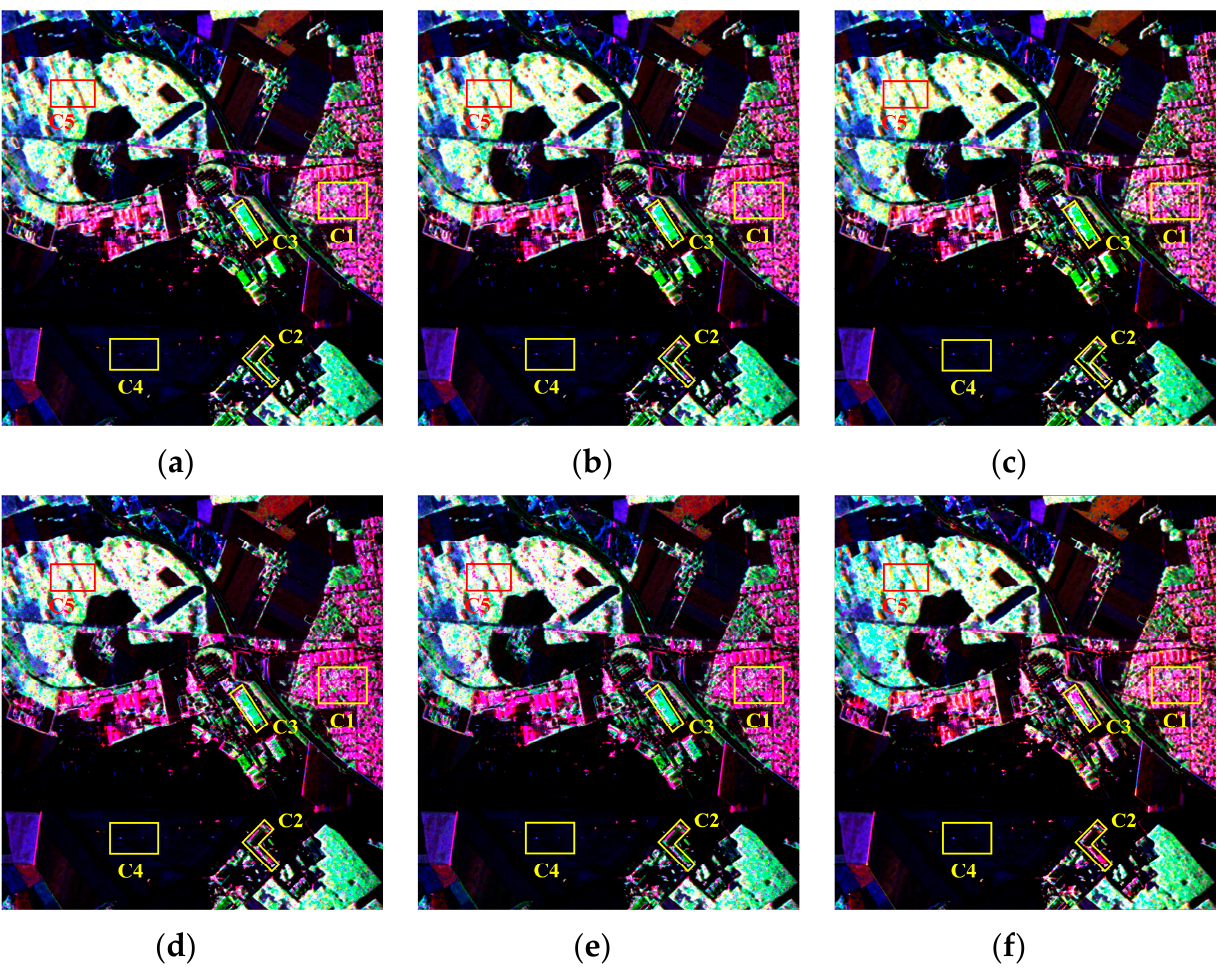
Figure 15. Decomposition results of E-SAR data sets over Oberpfaffenhofen, Germany (RGB com- ponent: red: double-bounce scattering, green: volume scattering, blue: surface scattering). ( a ) Y4O, ( b ) Y4R, ( c ) G4U, ( d ) 6SD, ( e ) 7SD, ( f ) MRDM-5SD.